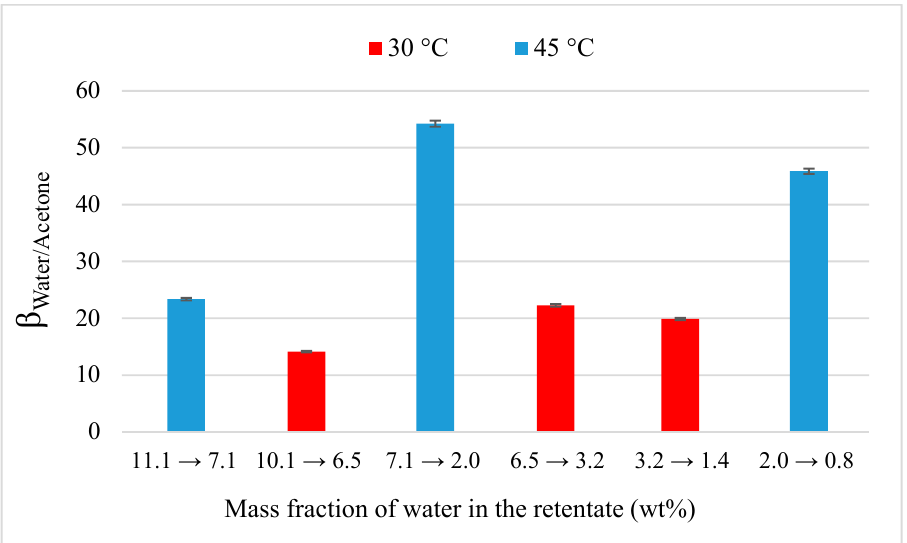
Figure 4. Evolution of separation factor water/acetone as the function of the inlet composition through M1 at 30 and 45 °C.